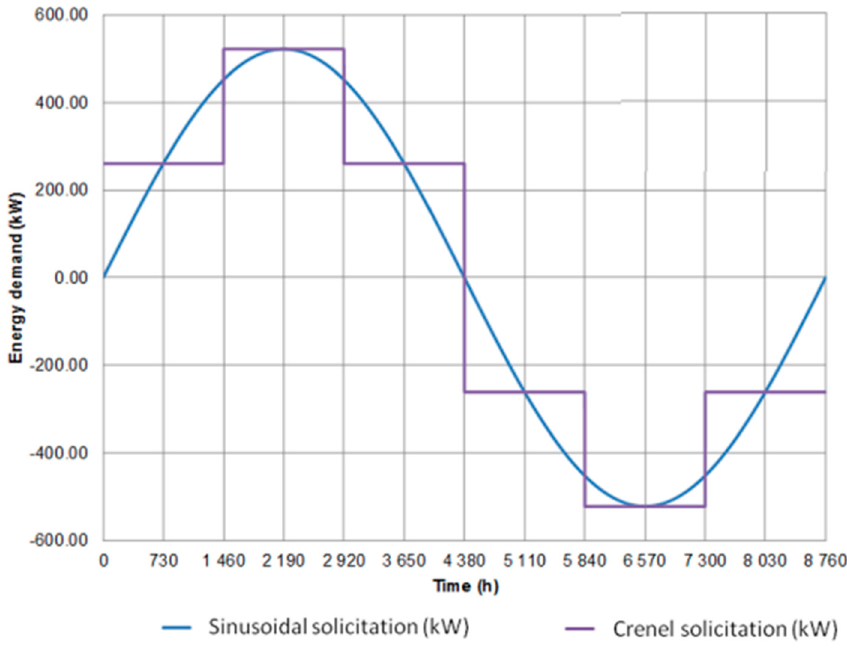
Figure 6. Example of crenel and sinusoidal signals used as a thermal solicitation.